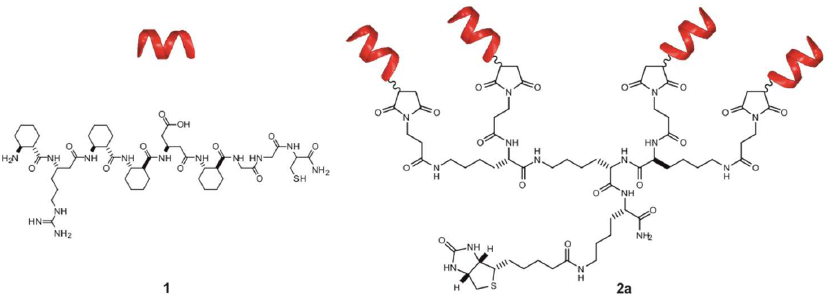
Figure 1. Sequence and schematic representation of recognition unit ( 1 ) and tetravalent conjugate ( 2a ).